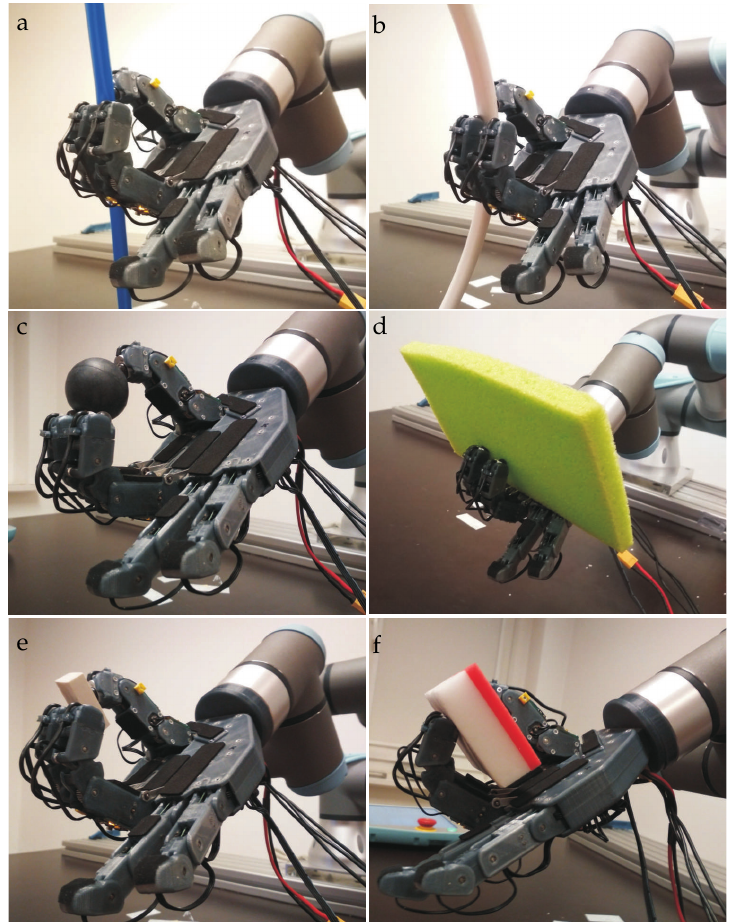
Figure 18. Objects grasped by the hand using force feedback: metal pipe ( a ), rubber pipe ( b ), squash ball ( c ), rubber eraser ( e ), and two types of foam ( d , f ).